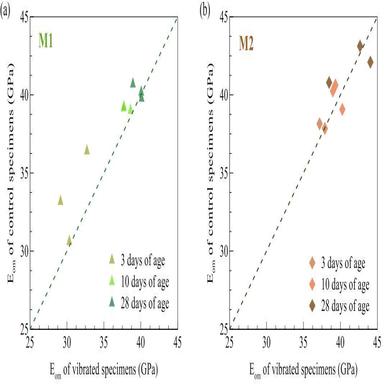
Modulus of elasticity Eom of vibrated vs control specimens: (a) M1 and (b) M2 mortar.